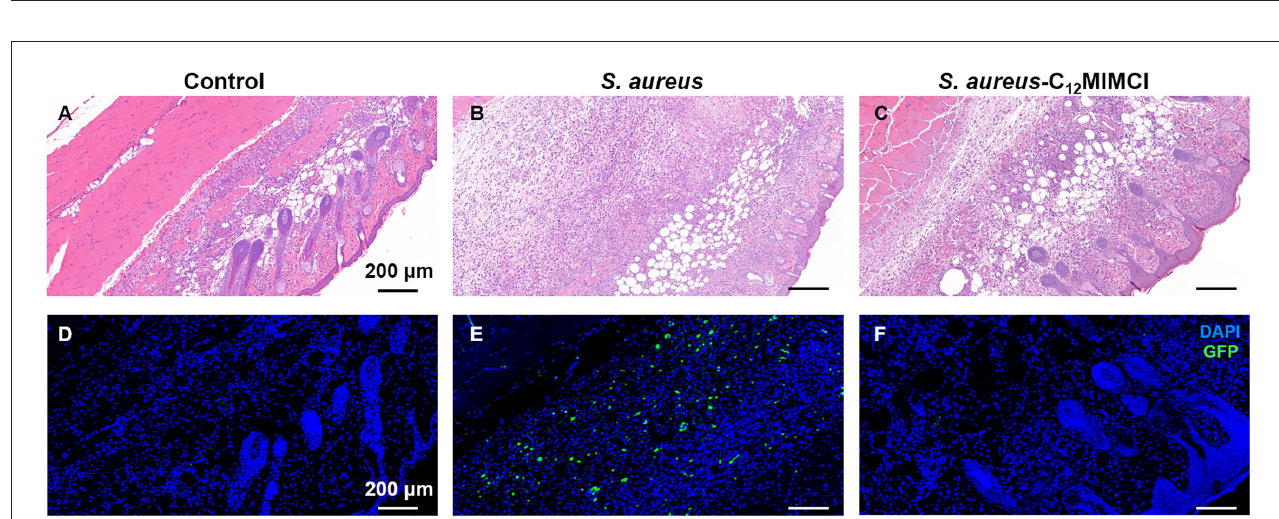
FIGURE9 Histopathology of skin abscess and fluorescent scan in mice after Staphylococcus aureus infection and C 12 MIMCl treatment. (A) Histopathology of the control group (PBS). (B) Histopathology of skin abscess after Staphylococcus aureus injection. (C) Histopathology of C 12 MIMCl treatment in skin abscess. (D) Fluorescent scan of the control group (PBS). (E) Fluorescent scan of skin abscess after S taphylococcus aureus injection. (F) Fluorescent scan of C 12 MIMCl treatment in skin abscess. DAPI (blue), GFP -Staphylococcus aureus (green).